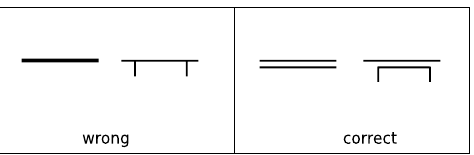
Figure 4.3: Edges must not overlap node borders.